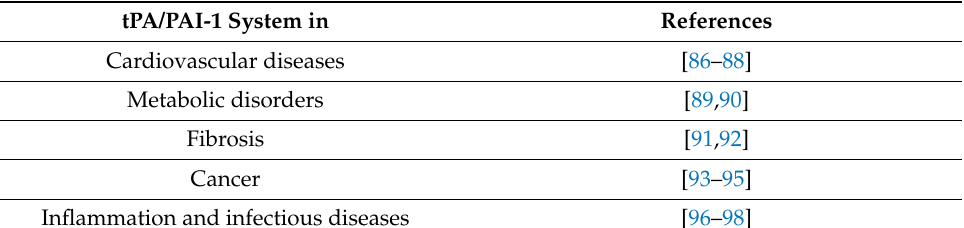
Table 1. Non-exhaustive list of reviews covering pathological conditions outside the CNS linked with tPA/PAI-1 balance